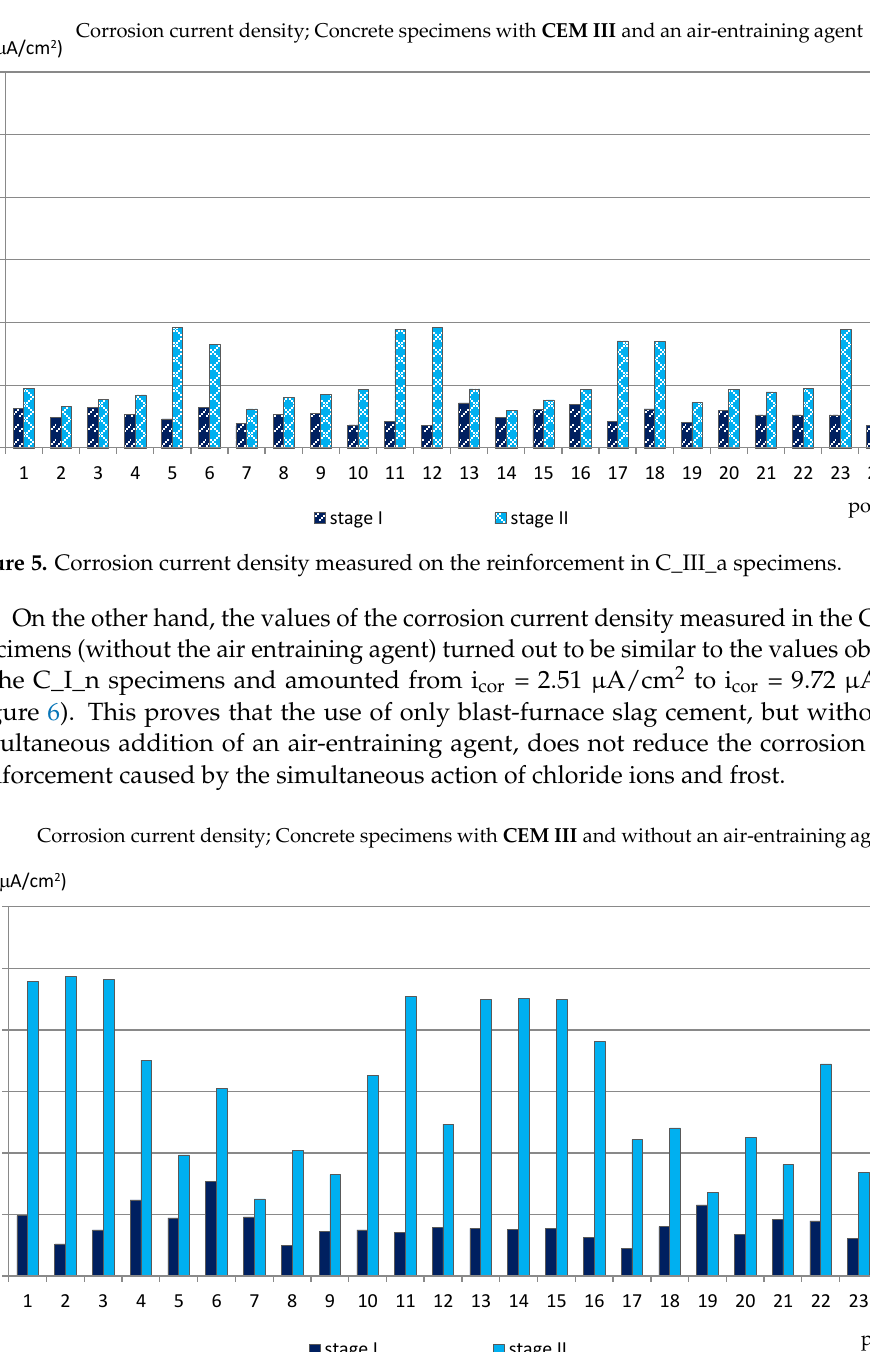
8 of 17 Figure 4. Corrosion current density measured on the reinforcement in C_I_n specimens.